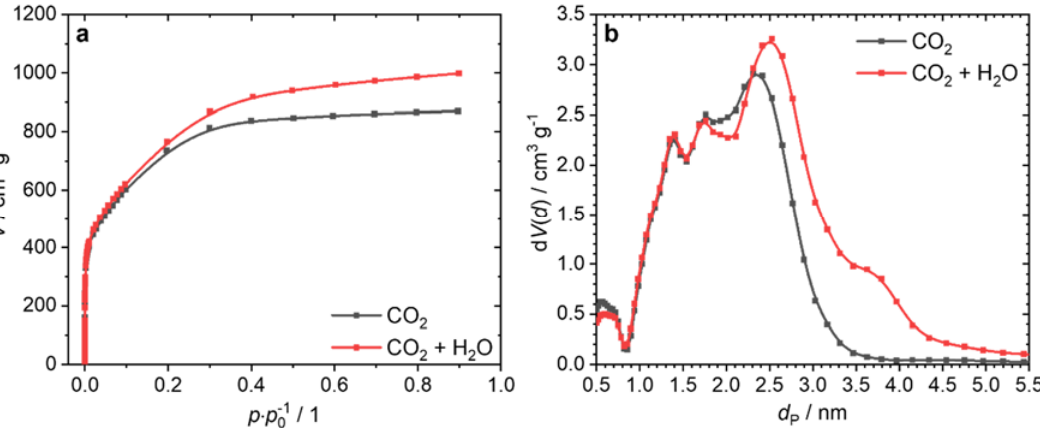
Figure 5. Isotherms ( a ) and PSDs ( b ) of the ACFs activated with CO 2 , and with CO 2 followed by H 2 O (N2; 77 K; NLDFT; slit ‐ pore model).